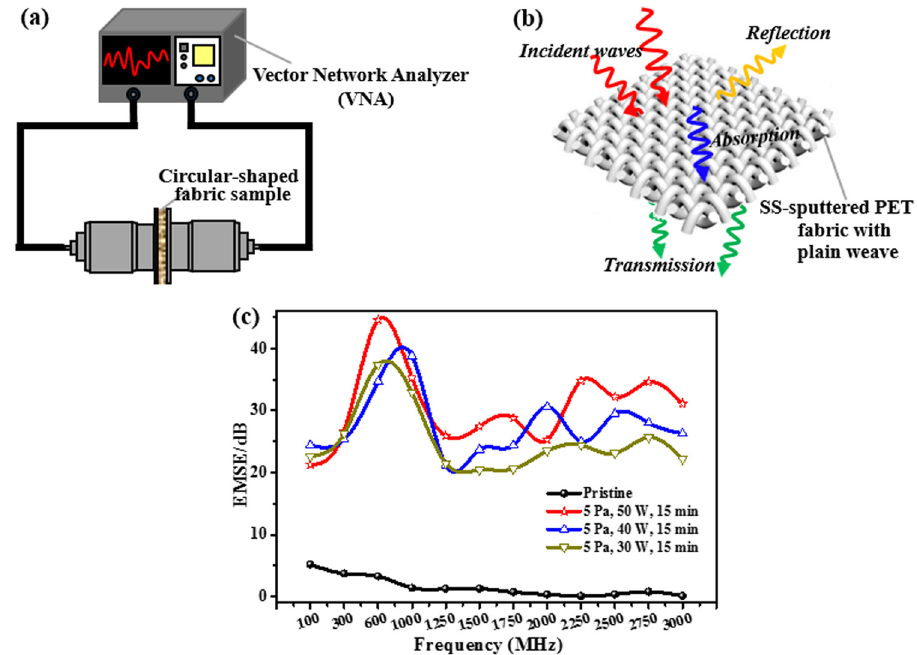
Figure 7: ( a ) Sketch of electromagnetic shielding testing system; ( b ) schematic of electromagnetic waves on passing through SS - sputtered PET fabric; and ( c ) EMSE under di ff erent sputtering